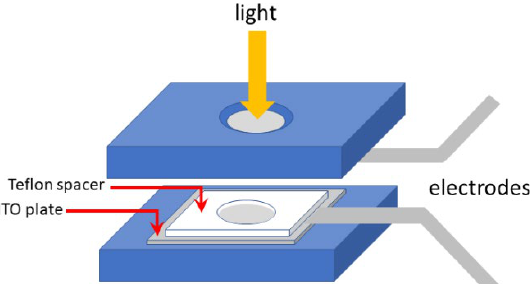
Figure 12. Device used for measuring the conductivity of the different gels. The gel was cast within the hole of the 1 mm thick pacer. The electrodes were placed on each face of the gel before closing the system. Light could be shone onto the sample to oxidize the TATA moiety, as shown.